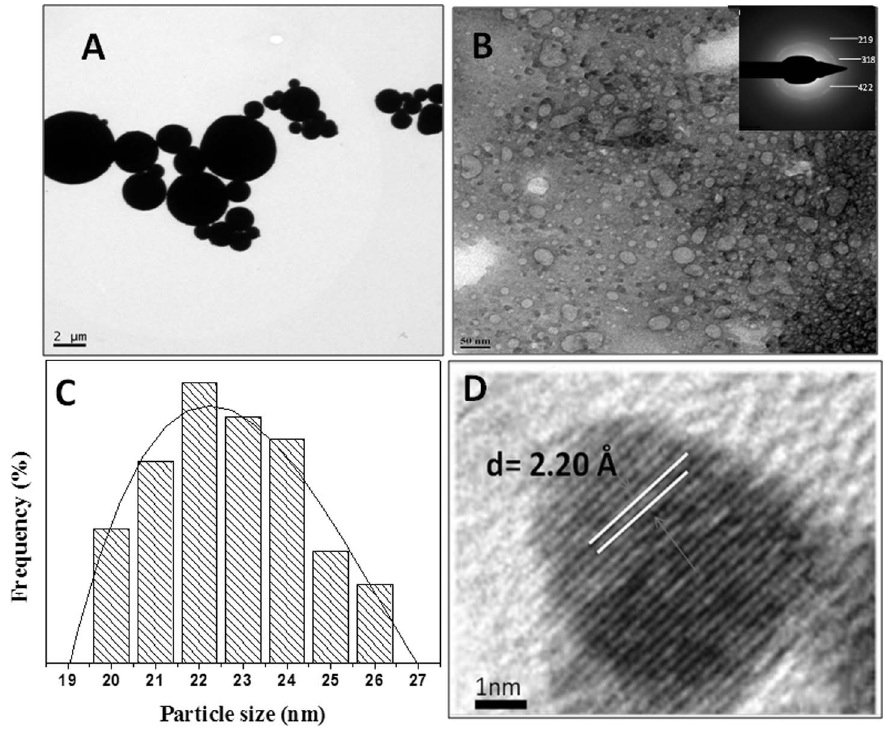
Figure 3. Transmission Electron Microscopic image of Fly-ash powder(A), bioleached silica nanoparticles obtained after reacting Fly-ash with Fusariumoxysporum for 24 h(B) inset shows selected area electron diffraction (SAED) analysis of bioleached silica nanoparticles, particle size distribution analysis of bioleached silica nanoparticles(C) and HR-TEM image of bioleached silica nanoparticles (D).